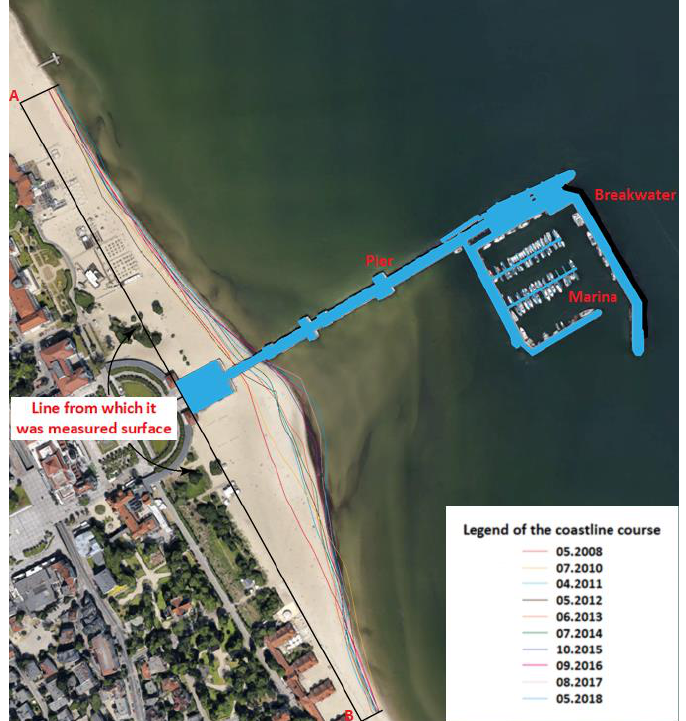
Figure 2. The course of the beach shoreline in Sopot over the years 2008–2018 (with an orthophotomap from 2018). Own study based on [4]. from 2018). Own study based on